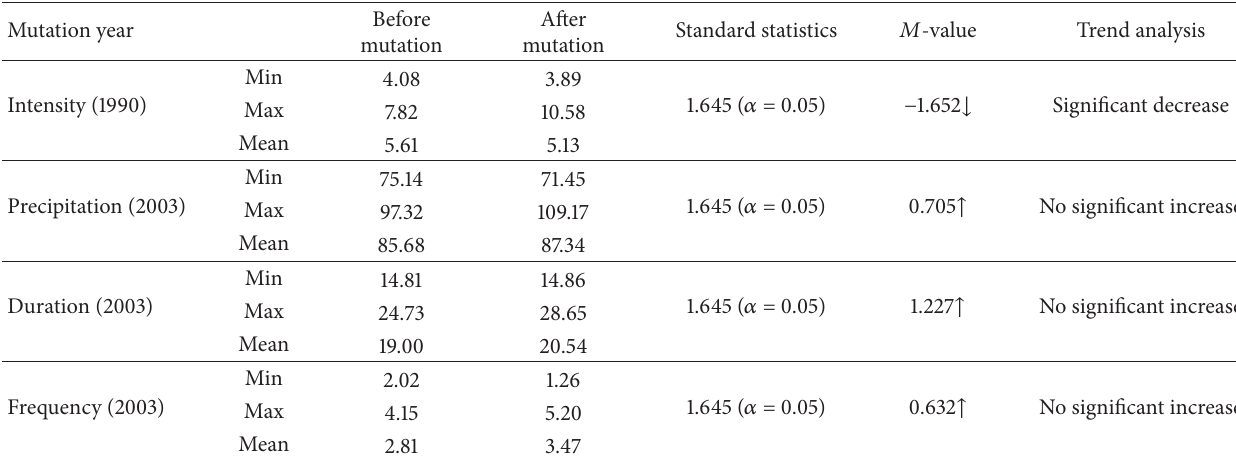
Figure 10: Spatial distribution of isolated rainstorm event intensity during 1950s–2000s. Table 3: Mutation and trend analysis of each